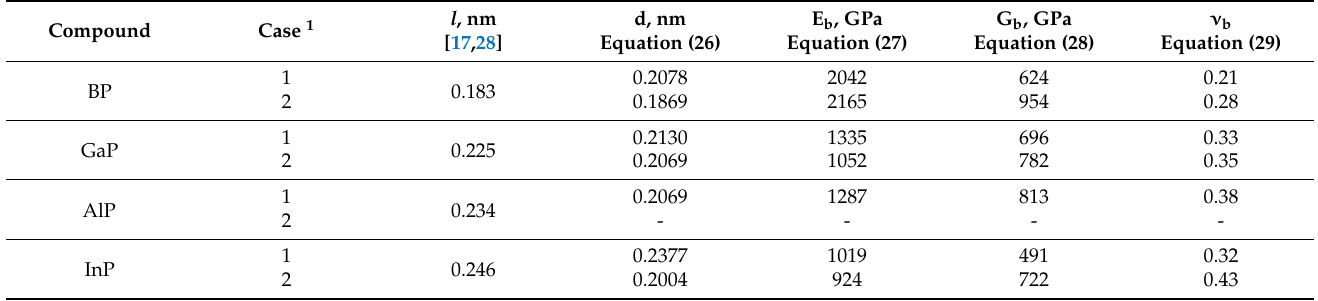
Table 4. Geometrical and elastic properties of the beam element (input values for FE simulations).